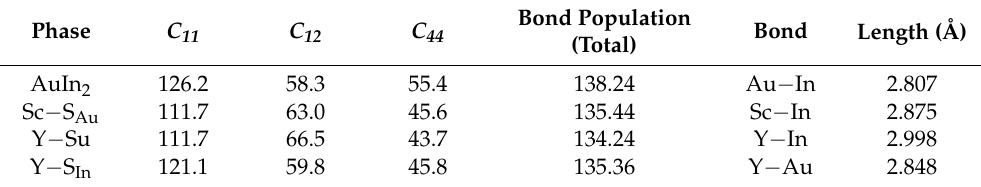
of AuIn 2 and doped